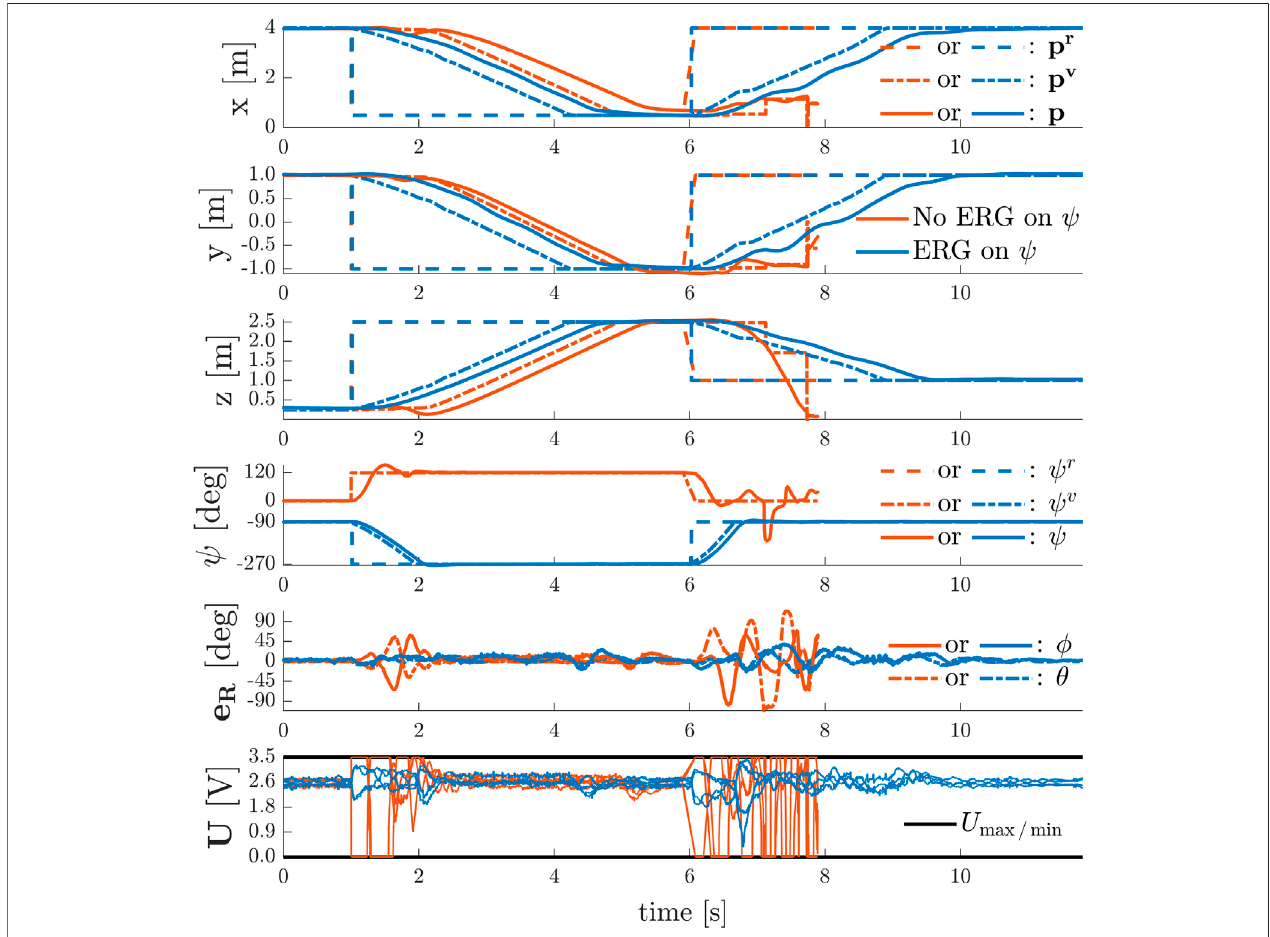
FIGURE 9| Simultaneous Point-to-Point Transitions and DiscontinuousYaw References With and Without Violation ofInput Constraints − Besides an ERG on the position variables that limits the total thrust, an invariance based ERG on the yaw axis is required to ensure safety for non-stationary yaw references.